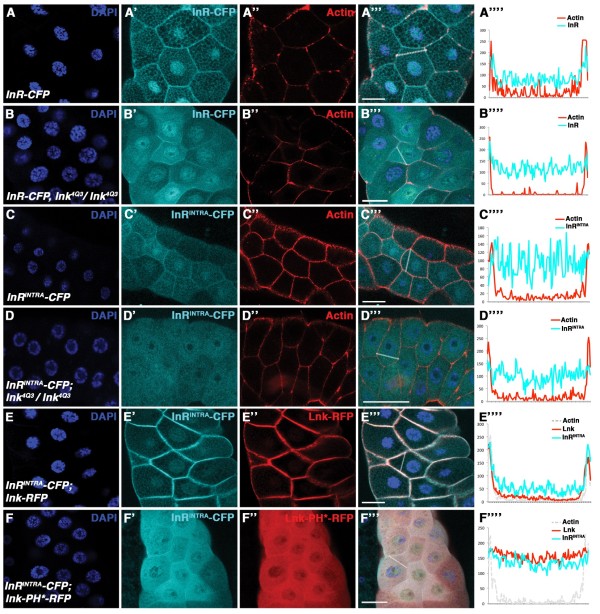
Lnk recruits the intracellular part of InR to the membrane. CFP-tagged InR (fragments) are shown in ’ panels. Actin staining marks the cellular cortex in ” panels except for E and F where Lnk-RFP is shown in the ” panels. Merged pictures are shown in ”’ panels. Signal intensities measured along the indicated lines in ”’ panels are displayed in ”” panels. Quantifications in Additional file 1: Figure S1B. (A-B) InR-CFP is substantially reduced at the cellular cortex in lnk mutant tissue (B-B””) in comparison to wild-type salivary glands (A-A””). (C-C””) Localisation of InRINTRA-CFP (C’) in wild-type tissue. (D-D””) InRINTRA-CFP in lnk−/− tissue. (E-E””) Co-localisation of InRINTRA-CFP (E’) and Lnk-RFP (E”) at the cellular membrane. (F-F””) Co-localisation of InRINTRA-CFP (F’) and Lnk-PH*-RFP (F”) in the cytoplasm. Number of samples analysed: (A) n=5, (B) n=6, (C) n=6, (D) n=7, (E) n=6, (F) n = 5. Scale bars represent 50 μm.